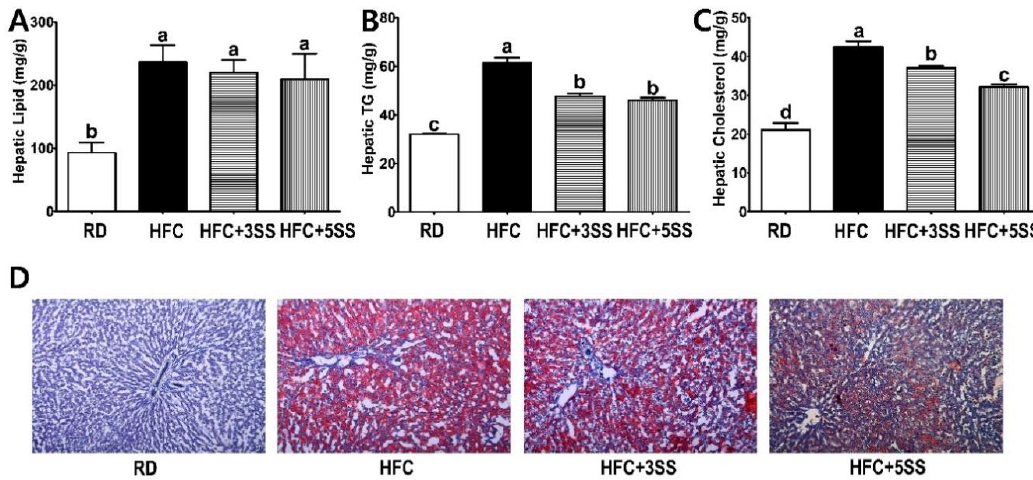
Figure 5. Effect of S. sieboldii Miq. root powder (SS) on hepatic lipid accumulation. Experimental rats were fed a regular diet (RD) or a high-fat and high-cholesterol (HFC) diet with or without Stachys sieboldii Miq. root powder (SS; 3 or 5%) supplementation for 6 weeks. ( A ) Hepatic lipid, ( B ) hepatic triglyceride (TG) and ( C ) hepatic cholesterol were measured and expressed as mg/g of tissue weight; ( D ) liver samples from each experimental group were harvested, fixed and stained with Oil red O. RD, regular diet; HFC, high-fat and high-cholesterol diet; HFC + 3SS, high-fat and high-cholesterol diet + 3% of Stachys sieboldii Miq. root powder; HFC + 5SS, high-fat and high-cholesterol diet + 5% of Stachys sieboldii Miq. root powder. Values are means ± standard deviation, n = 8. Data were analyzed using one-way ANOVA followed by Tukey’s post hoc test. Means labeled without a common letter differ significantly, p < 0.05.